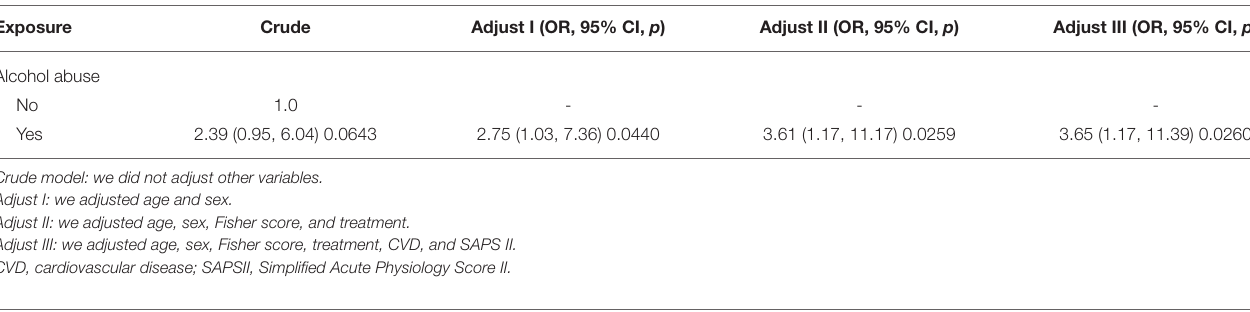
TABLE 5 | Relationship between alcohol abuse and DCI in different models by multivariable logistic regression analysis. Exposure Crude Adjust I (OR, 95% CI, p ) Adjust II (OR, 95% CI, p ) Adjust III (OR, 95% CI, p ) Alcohol